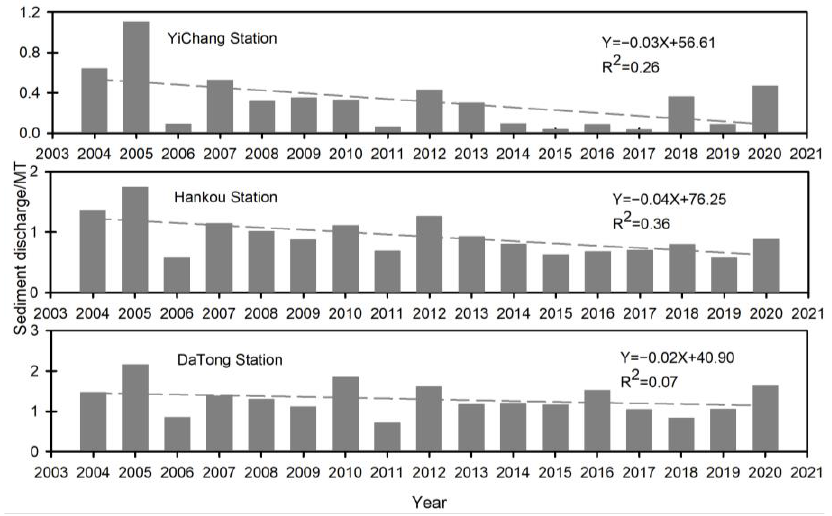
Figure 7. Sediment discharged data from hydrological stations in the mainstream YR from 2004 – 2020.